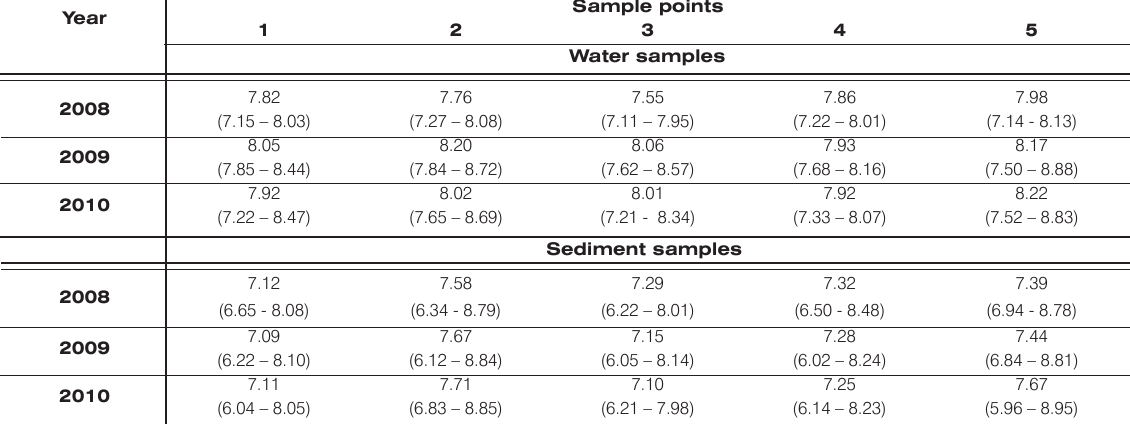
Table 1. pH values (average and min.–max.) in Kielce Lake water and sediment samples between July 2008 and May 2010 at particular